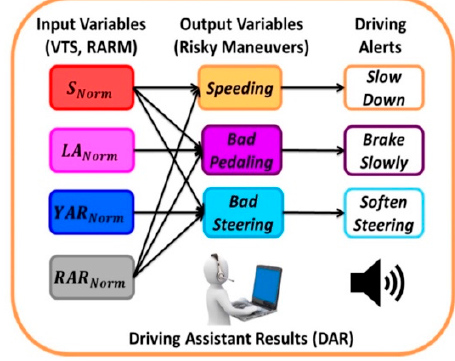
Figure 7. Driving assistant alerts.